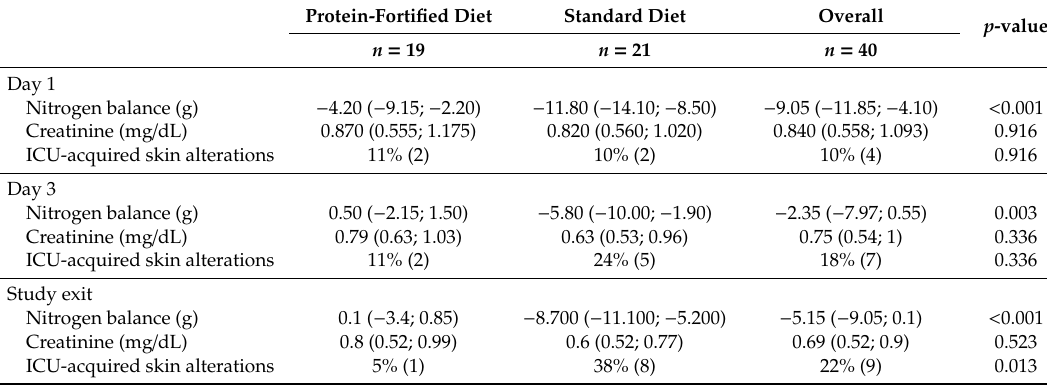
Table 2. Characteristics of the patients and the distribution of main nutritional indicators during follow-up (day 1, 3, and study exit).